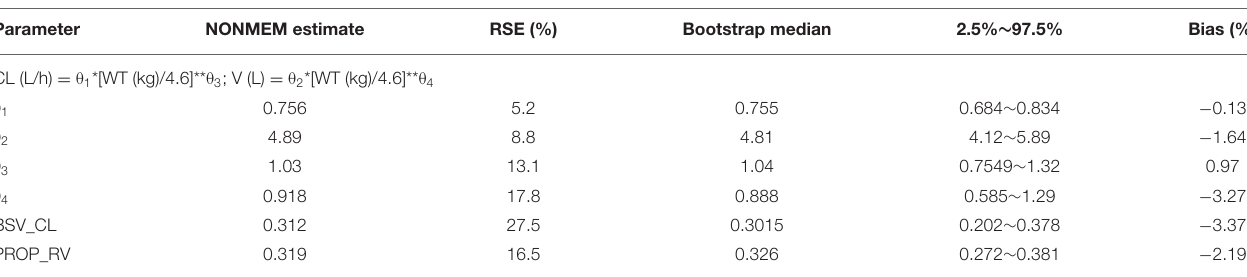
TABLE 6 | NONMEN estimates and bootstrap analysis of Model 2.